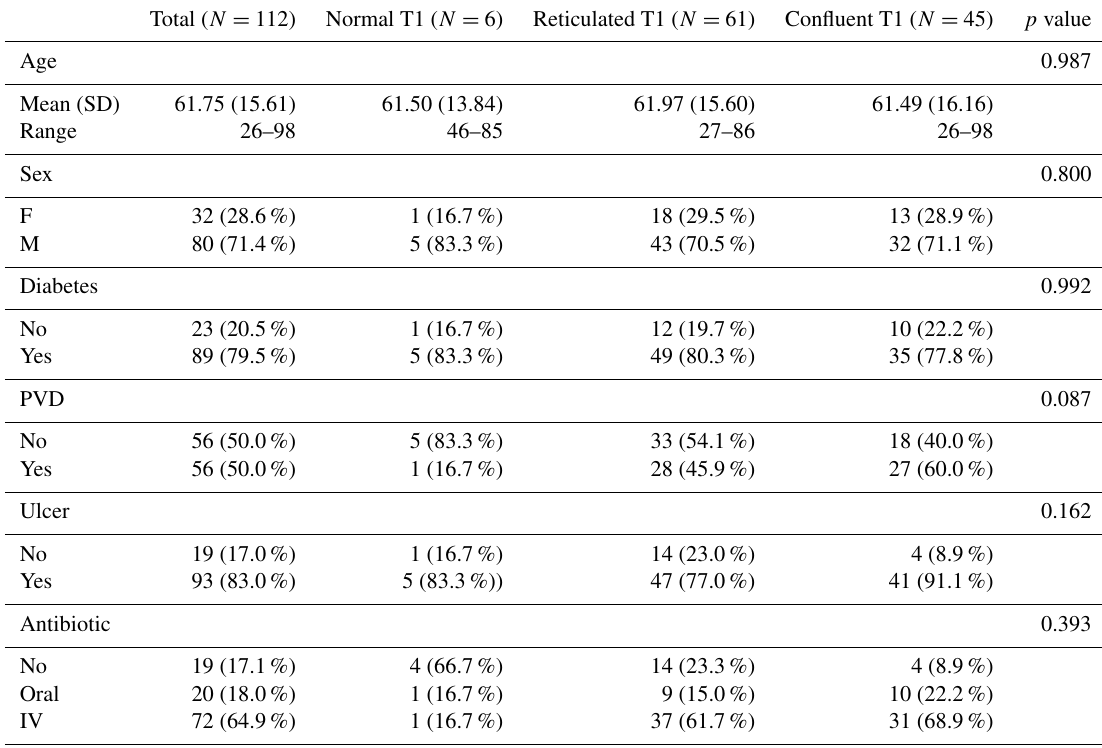
The abbreviations used in the table are as follows: SD – standard deviation, F – female, M – male, PVD – peripheral vascular disease, and IV – intravenous.